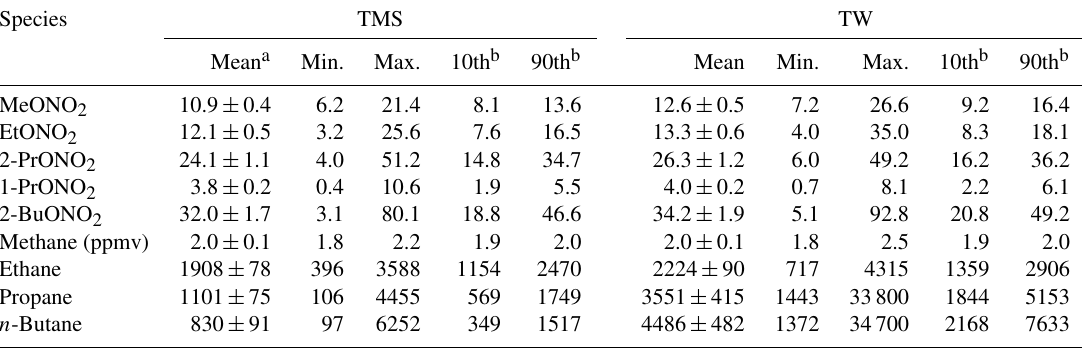
Table 1. Descriptive statistics of alkyl nitrates and parent hydrocarbons (pptv) in whole-air samples collected at TMS and TW during the sampling period.